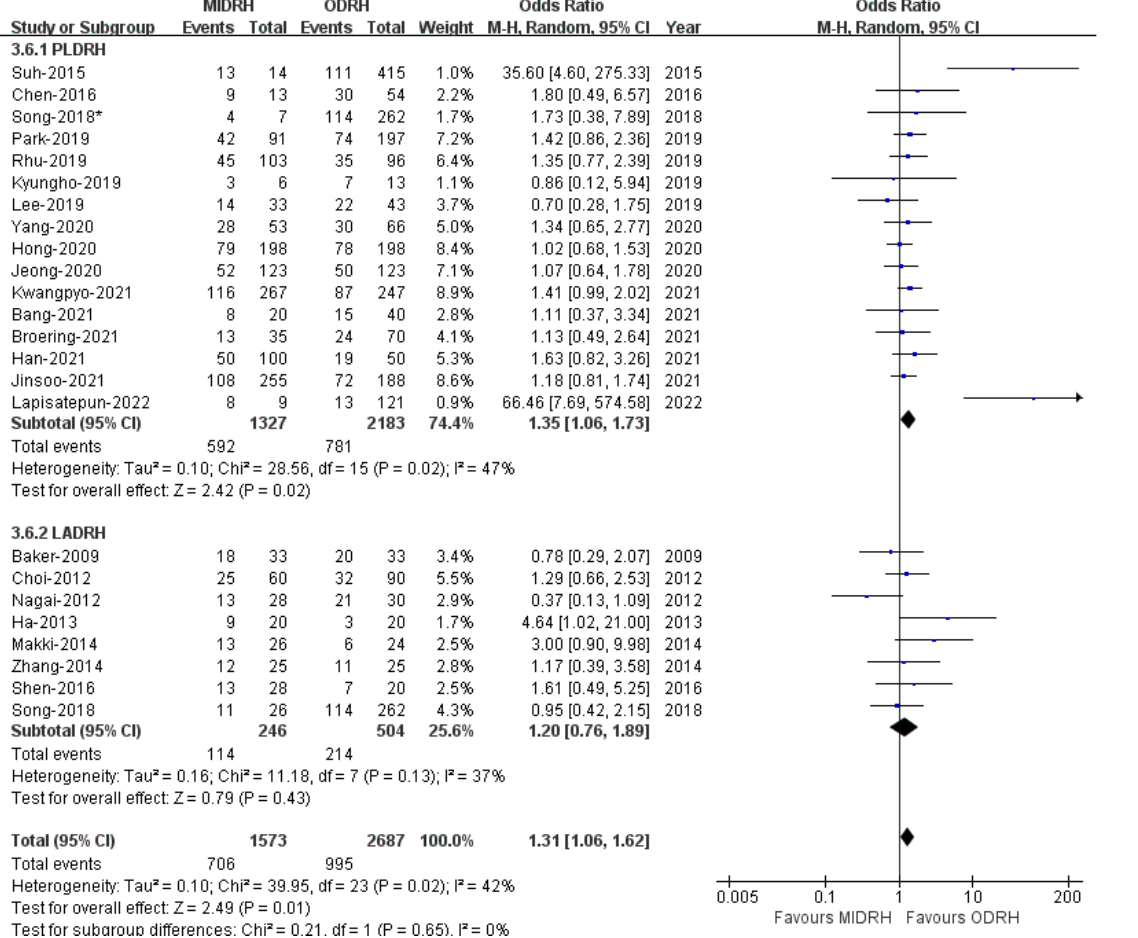
Figure 3. Forest plot of comparison of MIDRH versus ODRH for gender [1,4–7,12–15,17–27,29–31]. * ： Different data in the same article .